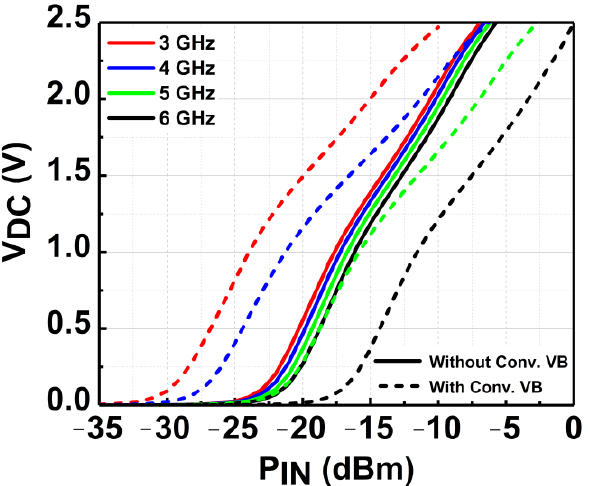
Figure 13. Simulated V DC of the CCDD rectifier with and without the conventional VB.